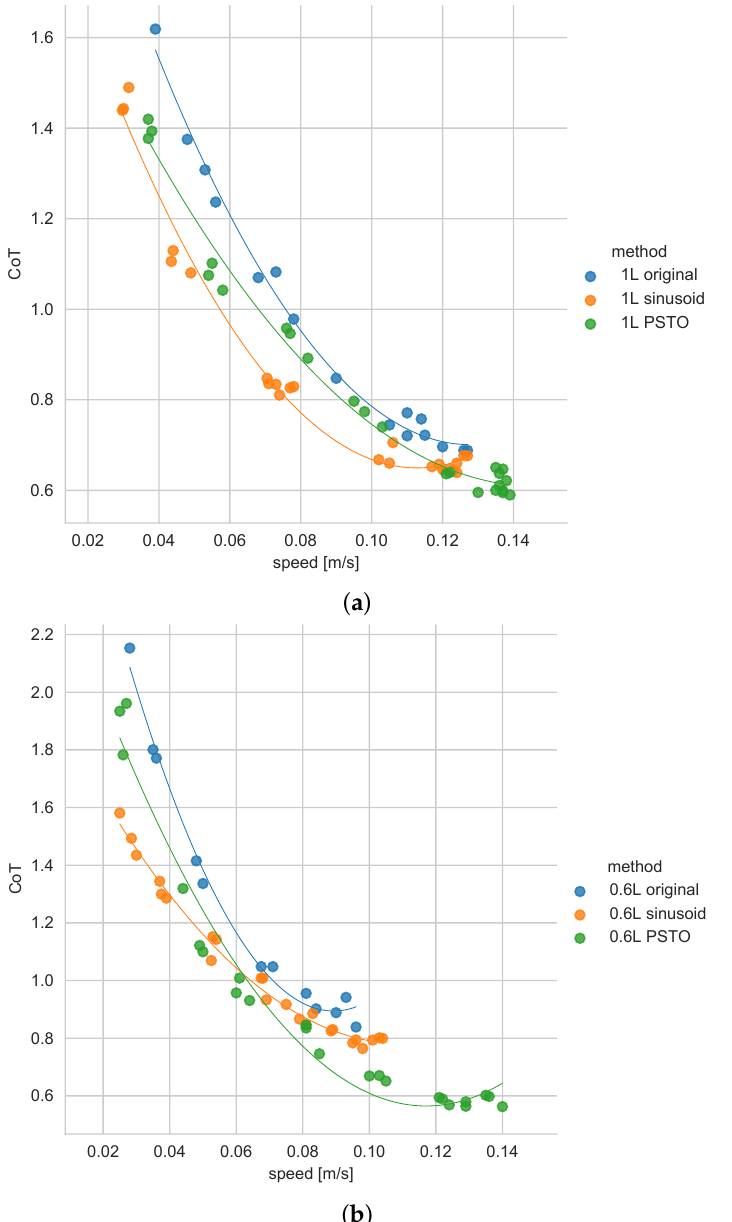
Figure 8. CoT related to speed [m/s] for original trajectory, sinusoid trajectory, and PSTO with trajectory amplification from 1.0 to 2.4 for 1 L leg length ( a ) and 0.6 L leg length ( b ) in the real-world experiments. The curves are the 2nd order polynomial regression for the tendency of three methods. At low speed, the sinusoid method is more competitive with low CoT than other methods while PSTO can achieve higher speed and lower CoT with the increasing amplification for both 1 L and 0.6 L leg